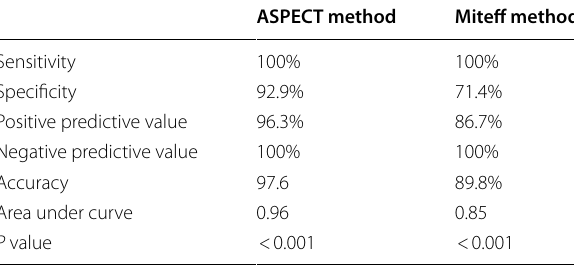
Table 5 ASPECT and Miteff methods in prediction of good functional